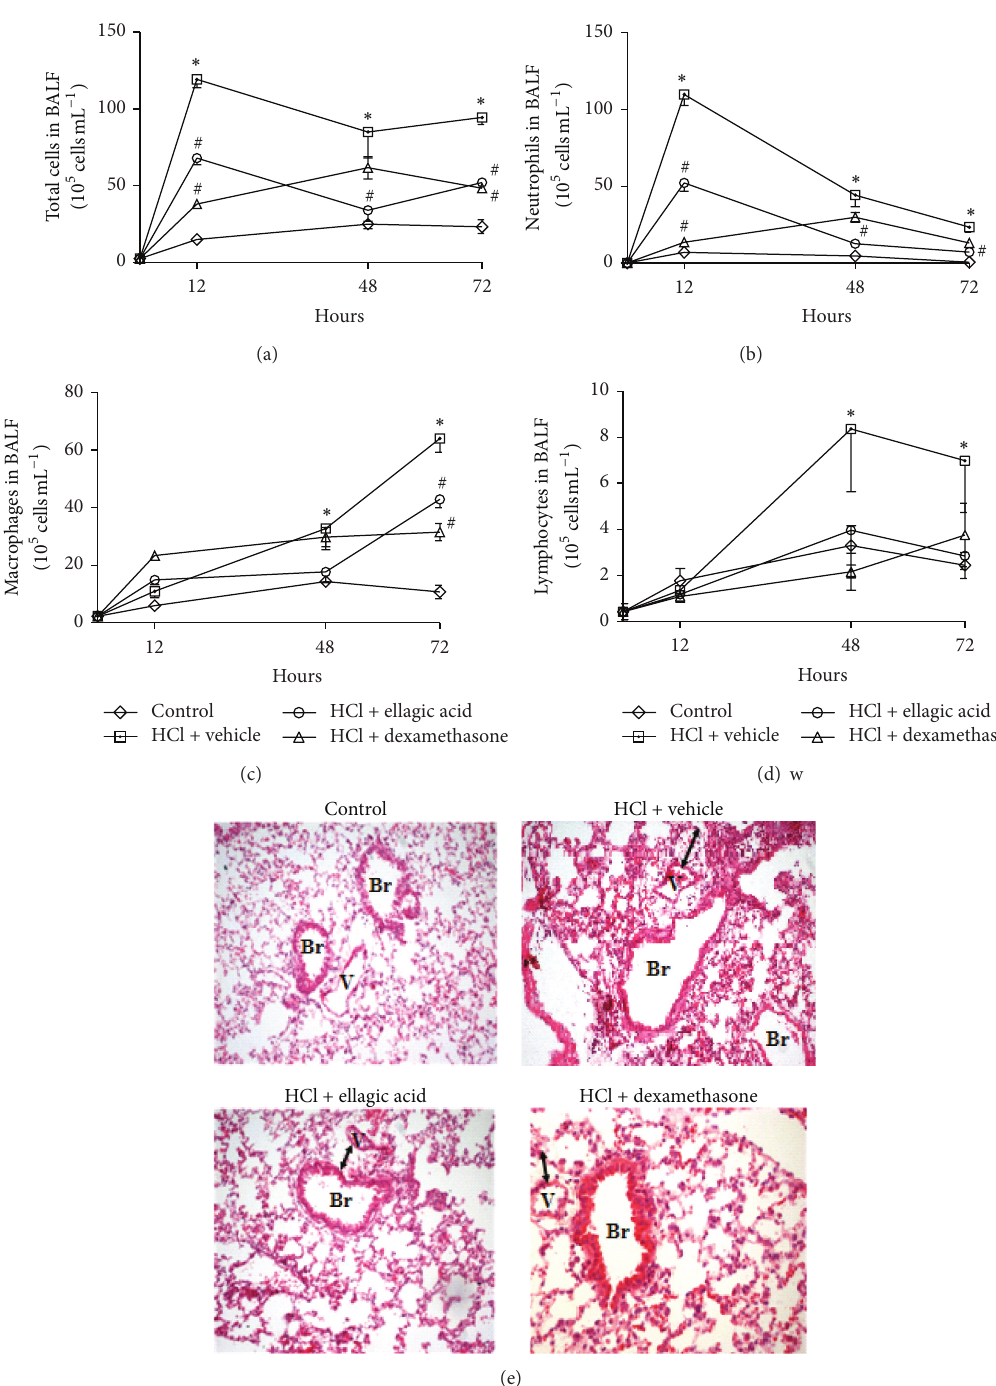
Figure 2: Ellagic acid demonstrates therapeutic anti-inflammatory activity in the experimental model acid-initiated acute lung injury. Mice received ellagic acid (10mg/kg, p.o.), dexamethasone (1mg/kg, s.c.), or vehicle (water, p.o.) after (2, 24, 47, and/or 71h) the acid intratracheal instillation into the left lung (see Methods). The kinetics of inflammation was determined at 12, 48, and 72 hours after acid-initiated acute lung injury. (a) Total cells, (b) neutrophils, (c) macrophages, and (d) lymphocytes were evaluated in the BALF. One group of animals received saline intratracheal instillation (control group). (e) Lung tissue inflammation was assessed by hematoxylin and eosin staining (H&E, original magnification, 200x). Results represent the mean ± SEM of two or more independent experiments with three mice per group per experiment. ∗ 𝑃 < 0.05 compared with control group; # 𝑃 < 0.05 compared with HCl + vehicle group. Br: bronchus V: